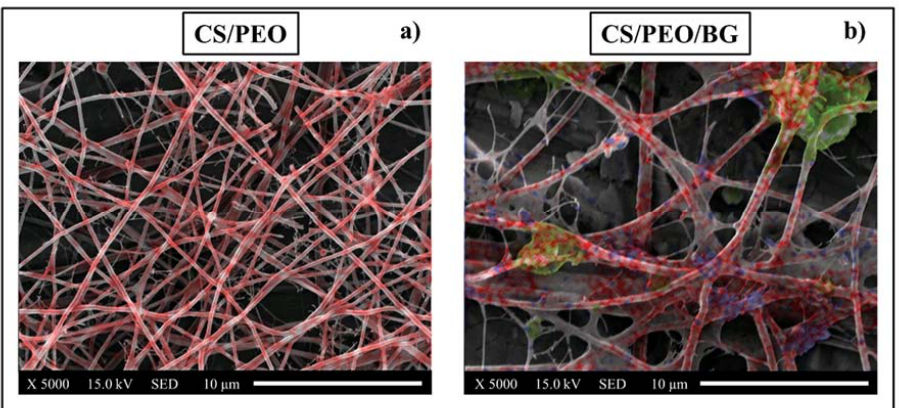
Figure 8. Images collected using EDX elemental maps pf CS/PEO (a) and CS/PEO/BG (b) converted in different colors (blue for calcium, green for silicon and red for carbon) and overlaid on the SEM images in order to verify the incorporation of bioglass inside the fibers. EDX maps and SEM images were collected at 5000X magnification.